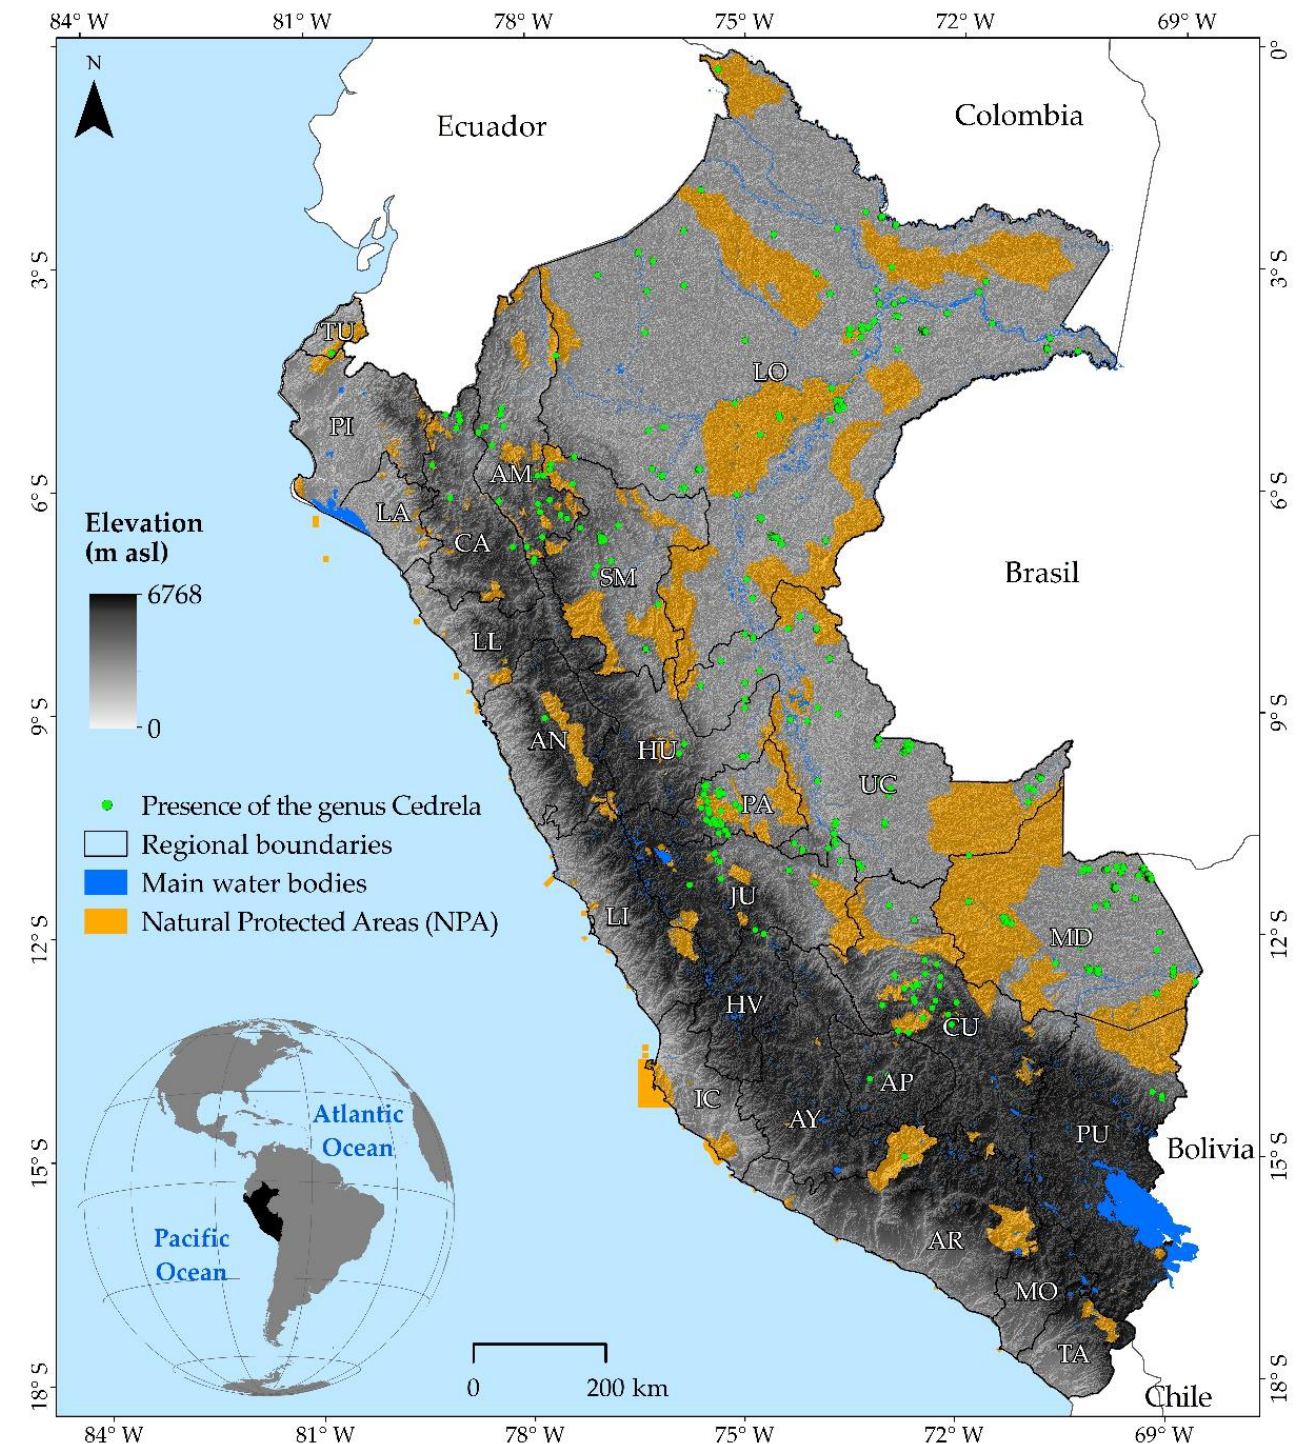
Figure 1. Study area and presence of Cedrela species .